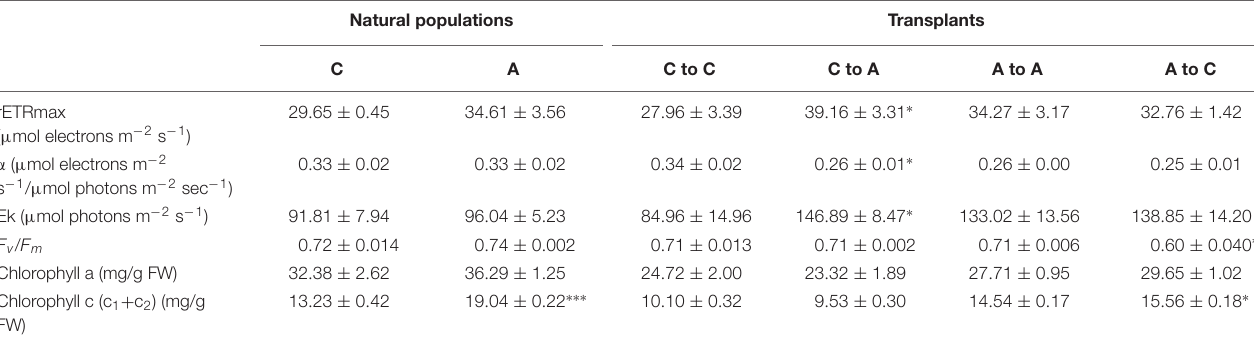
TABLE 1 | Photosynthetic parameters and pigment contents in S. vulgare collected at the acidified (A) and the control (C) site (natural populations) and after reciprocal transplants: C to C, control to control; C to A, control to acidified; A to A, acidified to acidified; A to C, acidified to control. Natural